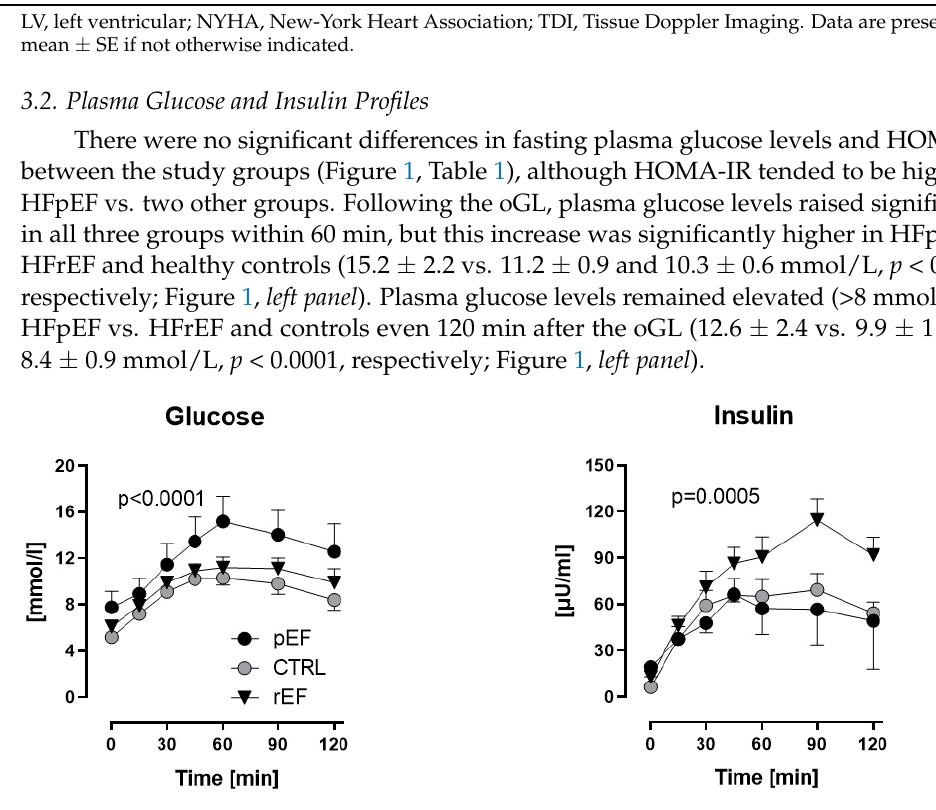
Figure 1. Plasma glucose and insulin levels in patients with heart failure with reduced ejection fraction (rEF, n = 12 men) or patients with preserved ejection fraction (pEF, n = 6 men) and healthy controls (n = 8 men) at baseline and after an oral glucose load (75 g). Data are given as mean ± SE; HFpEF vs. controls, p < 0.0001; HFrEF vs. controls, p = 0.0005. Fasting plasma insulin levels tended to be higher in HFrEF and HFpEF patients vs. controls (13.0 ± 2.1 and 19.3 ± 6.2 vs. 6.4 ± 0.7 µU/mL, p = 0.1, respectively; Figure 1). Plasma